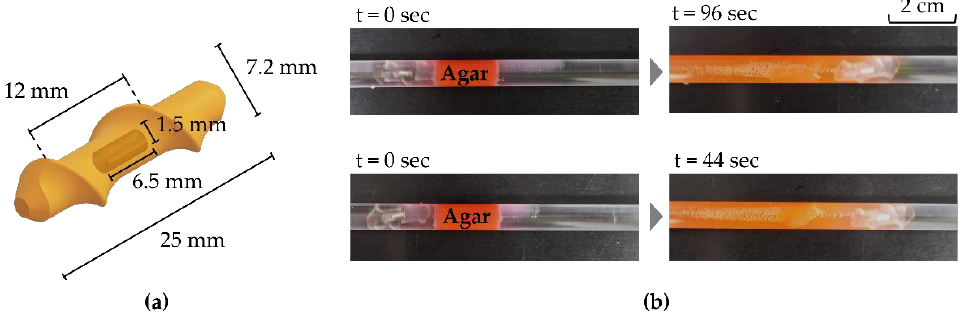
Figure 10. Performance test using a rotating magnetic field: ( a ) helical robot made of a diametrically magnetized cylindrical magnet (N52 grade) for the demonstration; ( b ) unclogging motion of the helical robot inside the optimized and conventional MNS. The optimized MNS and conventional MNS generated a 3D rotating magnetic field at 17 Hz and 12 Hz, respectively.